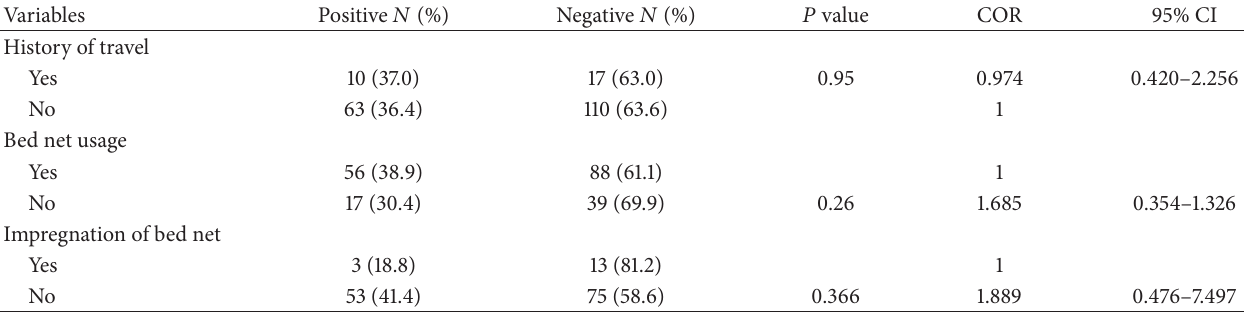
Table 5: Determinants associated with malaria in febrile patients at Ayinba Health Center, Northwest Ethiopia, from April to May 2013.